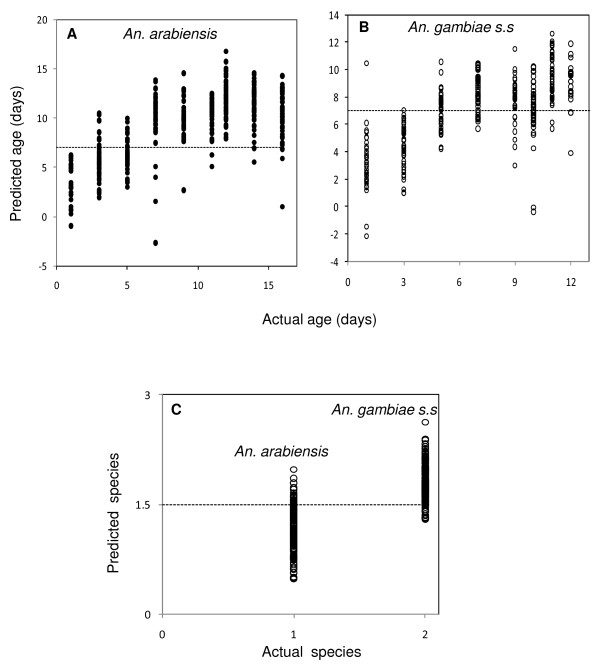
NIRS age and species prediction for semi-field reared An. arabiensis and An. gambiae s.s. as determined from a cross-validation. Panel A (An. arabiensis) and B (An. gambiae s.s.) indicate the actual age against the predicted age. The horizontal dotted line in Panel A and B separates young mosquitoes (<7 d) from old ones (≥7 d). Panel C shows the actual species (1 = An. arabiensis and 2 = An. gambiae s.s.) against the predicted species for 1, 5, 7, 11, 12 days old An. arabiensis and 1, 3, 5, 9, 10 days old An. gambiae s.s. The dotted line in panel C is the classification cut off point for the two sibling species (<1.5 for An. arabiensis and >1.5 for An. gambiae s.s.).